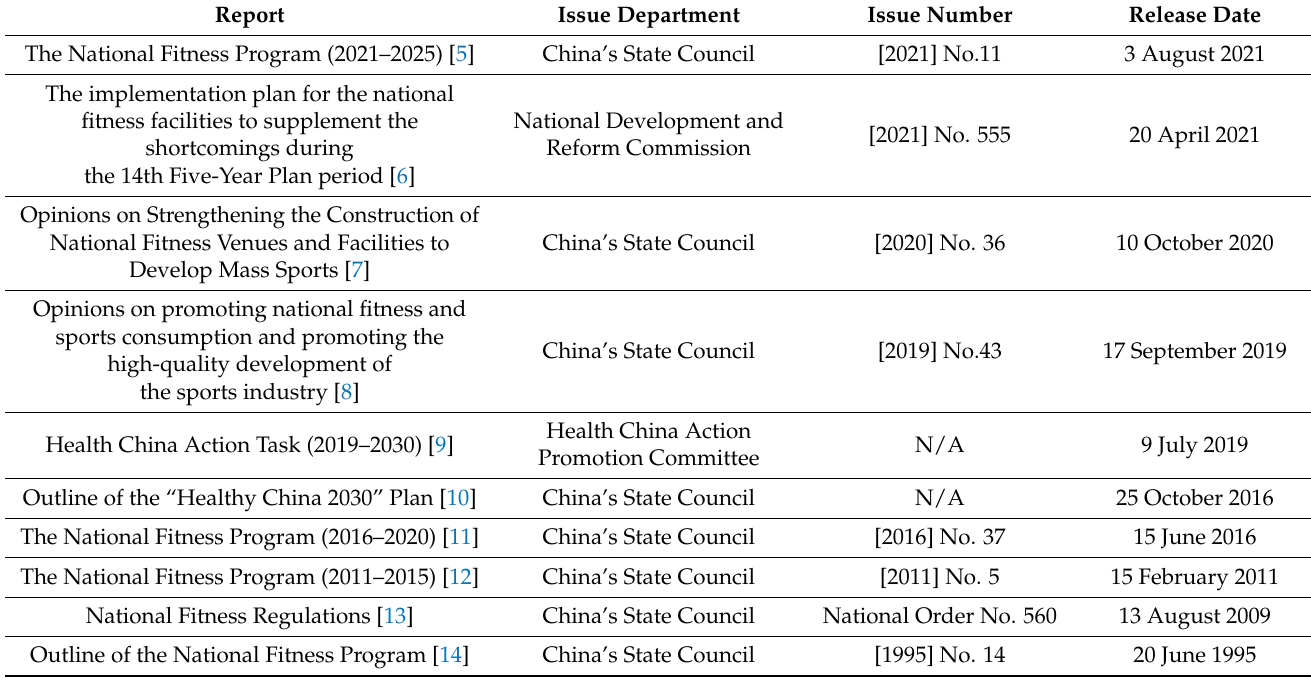
Table 1. Summary of key National Fitness policies in